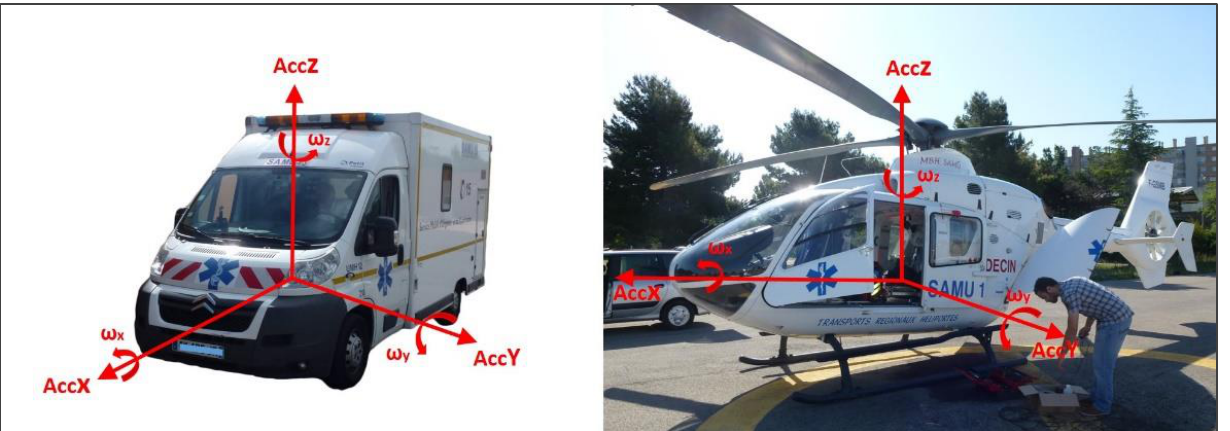
Figure 2. Coordinate system used for vehicles (ambulance and helicopter).